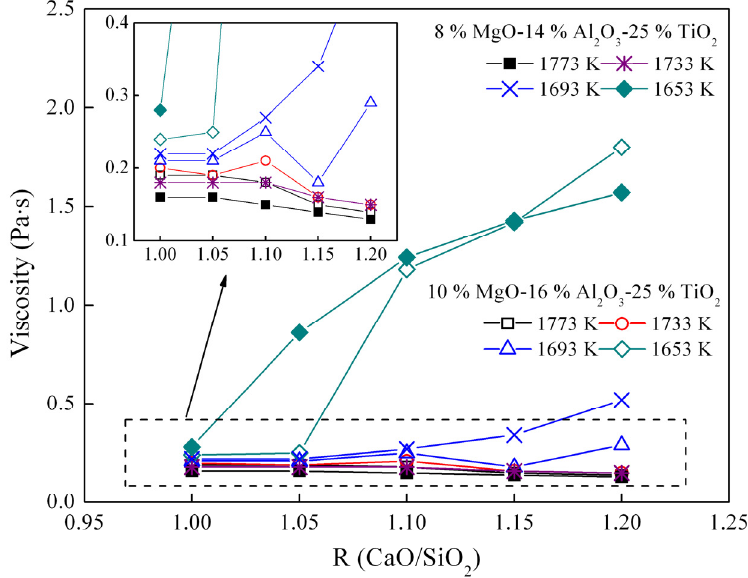
Figure 5. Viscosity of the CaO-SiO 2 -MgO-Al 2 O 3 -25 mass% TiO 2 slag as a function of basicity.